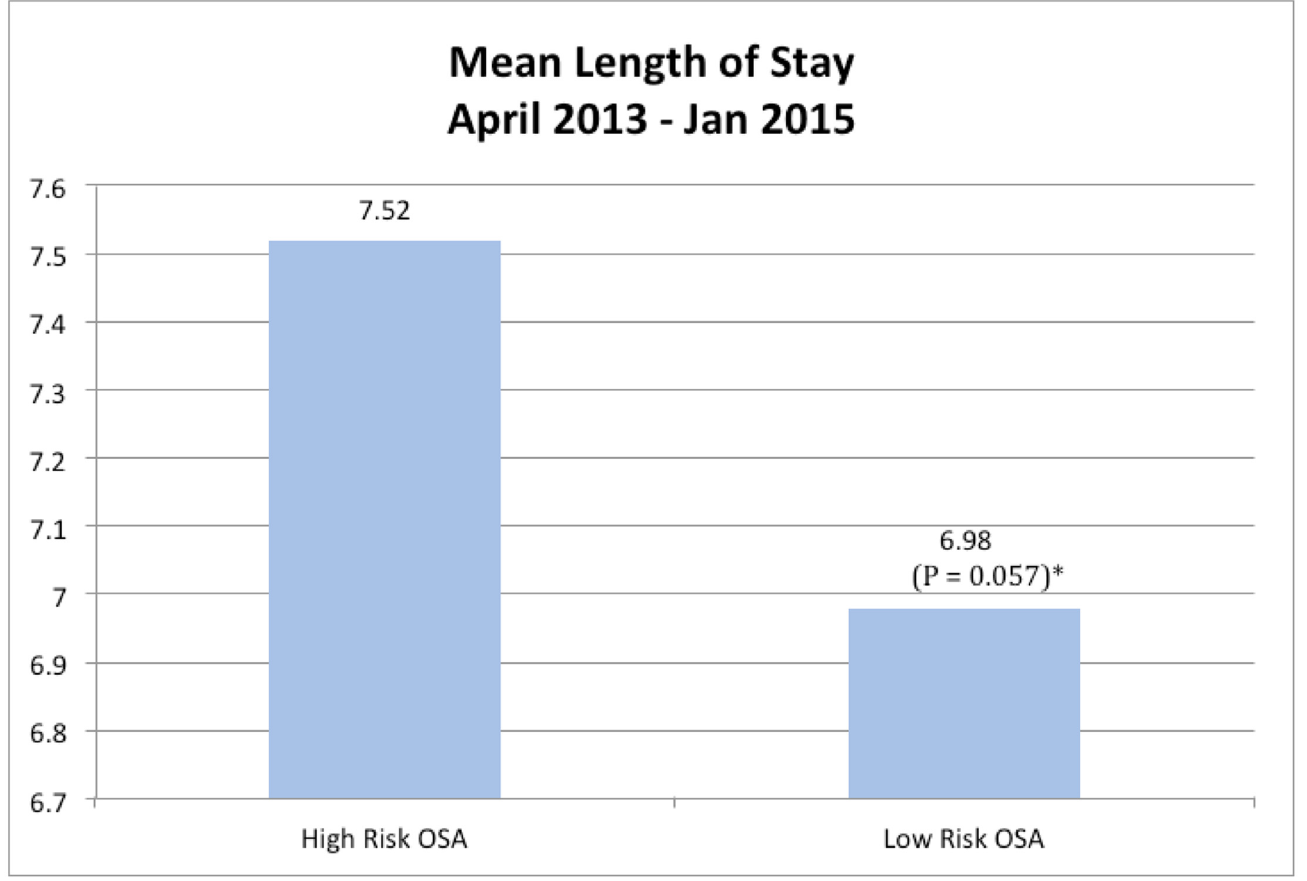
Fig 3. Comparison of mean length of stay in patients who were high risk for OSA versus low risk for OSA. doi:10.1371/journal.pone.0153790.g003 Table 1. Baseline characteristics comparison between sample of High-Risk and Low-Risk OSA patients selected randomly. Mean ± SD, Median /